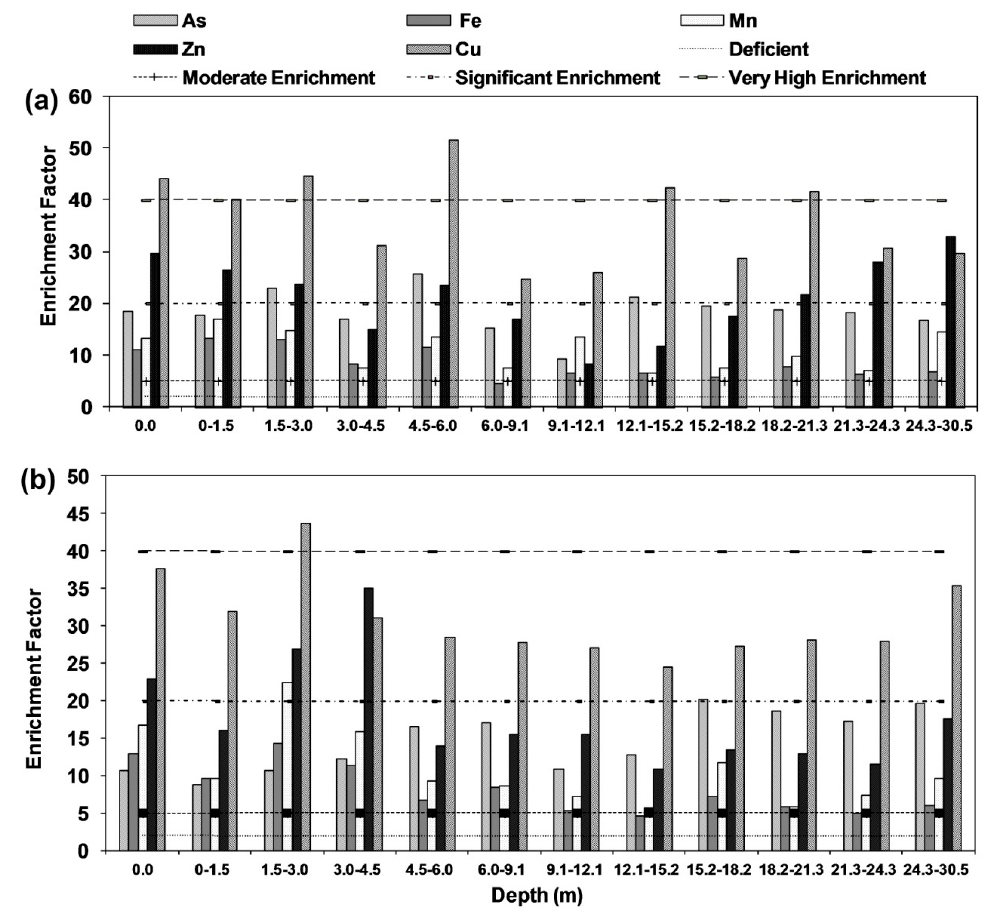
Figure 8. Calculated enrichment factor for As, Fe, Mn, Zn, and Cu ( a ) Rigni Chhapra ( b ) Chaube Chhapra.